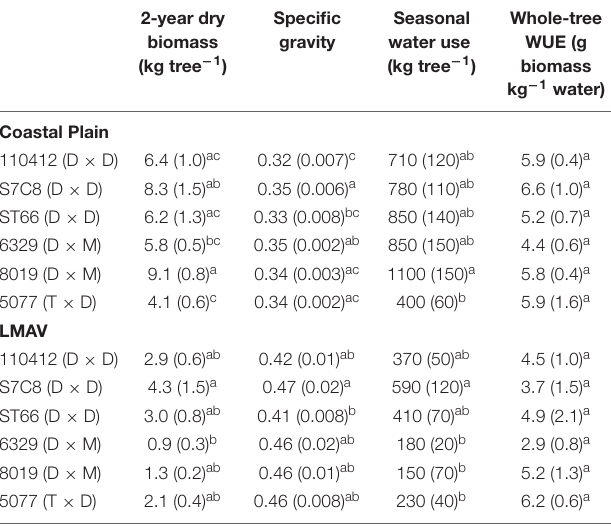
TABLE 2 | Productivity, water use, and water use efficiency (WUE) parameters (mean and SE in parentheses) for varietals growing on the Coastal Plain and LMAV